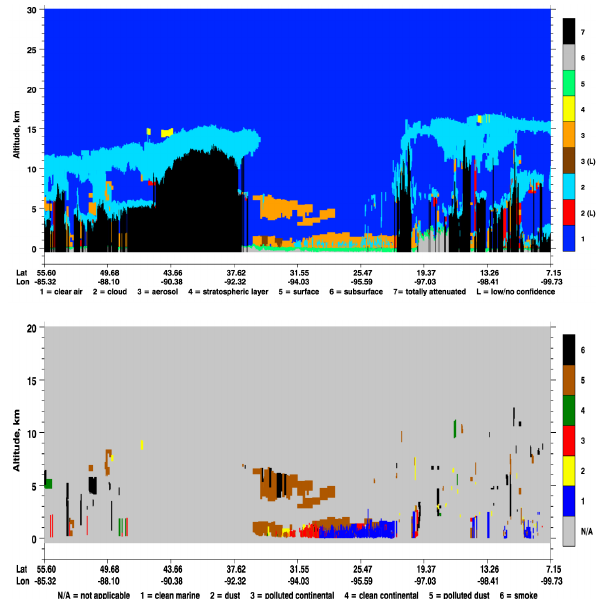
Fig. 14. CALIPSO vertical feature mask (top) and aerosol subtype (bottom) plots near CORALNet BLO on 25 June at approxi- mately 21:11UTC (http://www-calipso.larc.nasa.gov/products/ lidar/browse images/show date.php?s=production \ &v=V3-01 \ &browse date=2011-06-25).